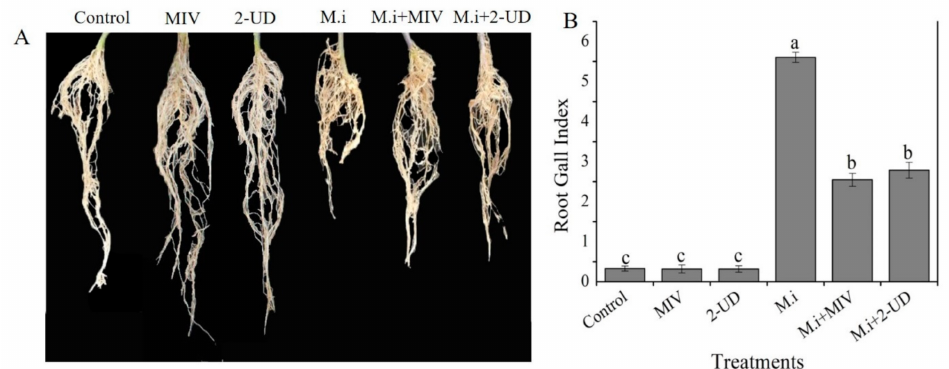
Figure 8. Reduction in the number of root galls in M. incognita (M.i)-infested plants after being exposed to pure volatiles, i.e., methyl isovalerate (MIV) and 2-undecanone (2-UD), up to 40 days was observed visually in pot experiments. ( A ) The effect of volatiles on root length and reduction in root gall in an infested plant (M.i) after being exposed to volatiles. ( B ) Graphical information of root gall reduction in the term of root gall index in infested plant pre-exposed to MIV and 2-UD. The error bar represents the mean standard deviation of each treatment repeated three times with three replicates. The small letters above the columns indicate significant difference. The significant difference between different treatments was calculated through Tukey’s HSD test at p ≤ 0.05.